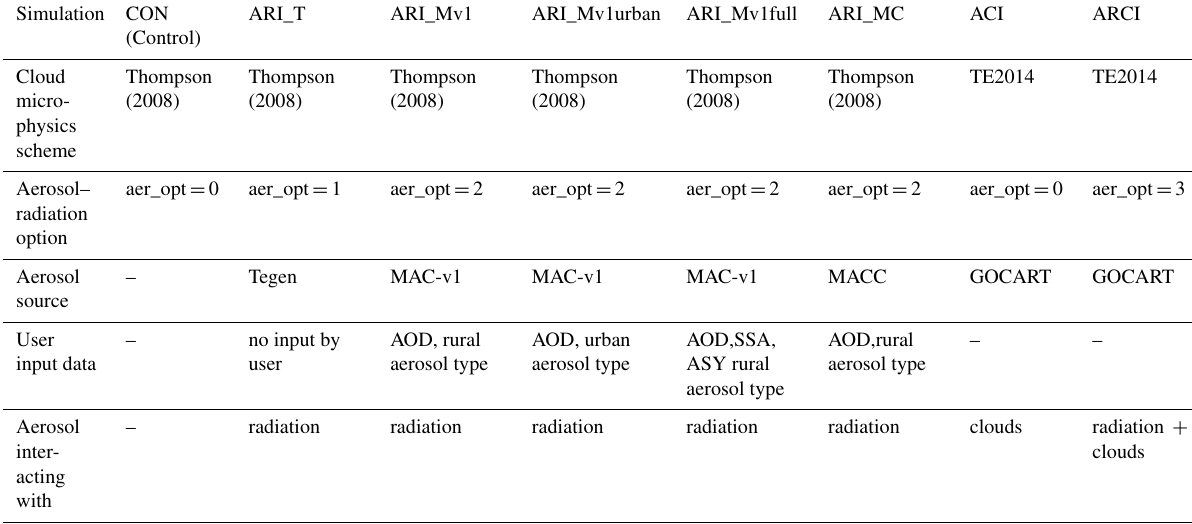
Table 1. Simulations conducted and description of aerosol treatment. Simulation CON (Control) Cloud